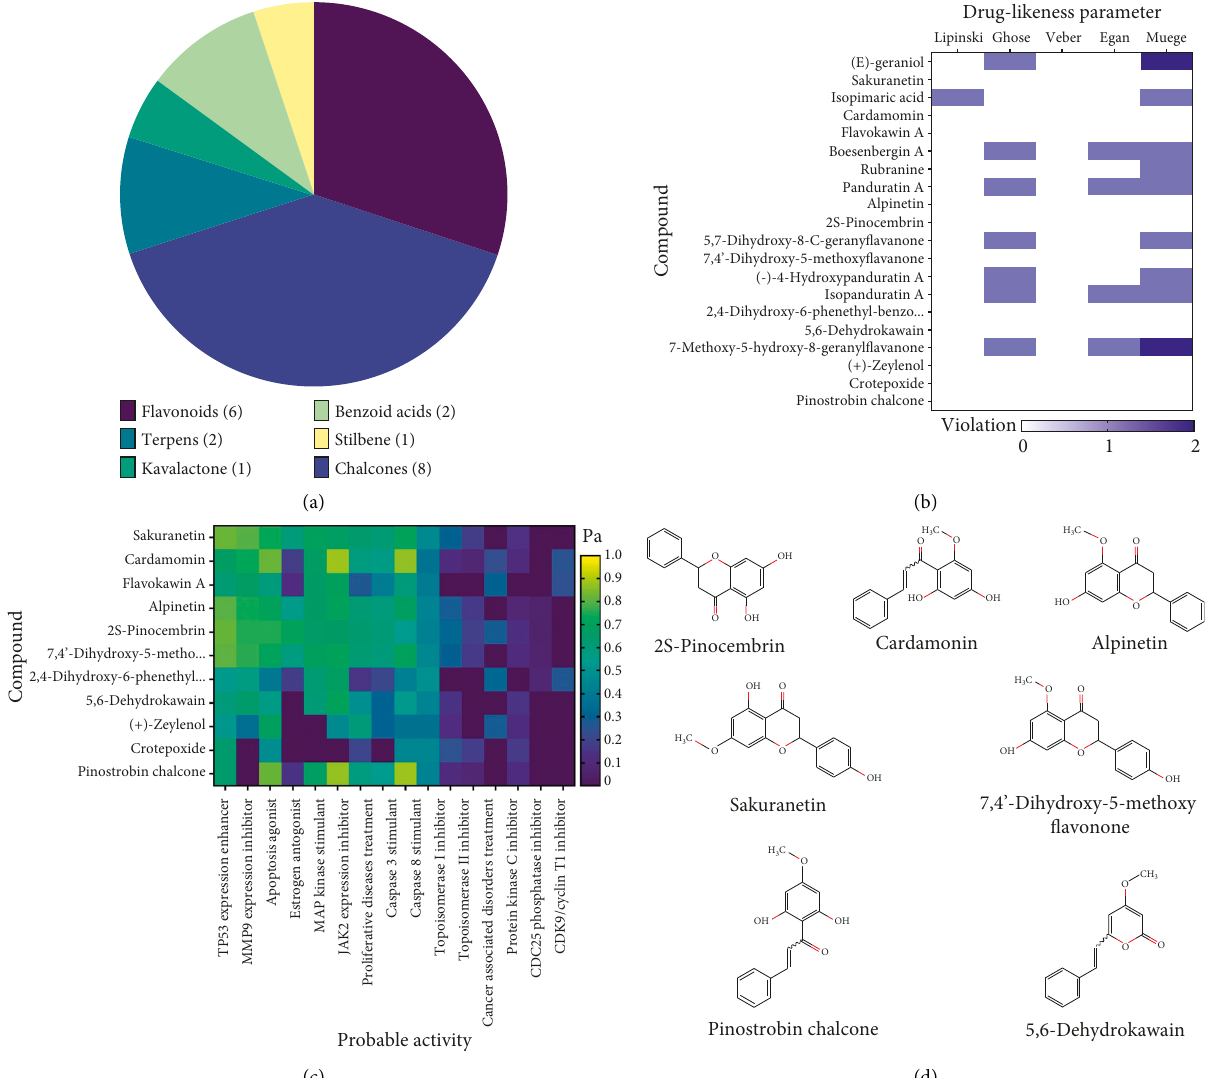
Figure 1: Bioactive compounds contained in B. rotunda . (a) Group of bioactive compounds contained in B. rotunda based on the KNApSAcK database. (b) Druglikeness screening. (c) PASS online screening. (d) The seven compounds that met the druglikeness and probable activity